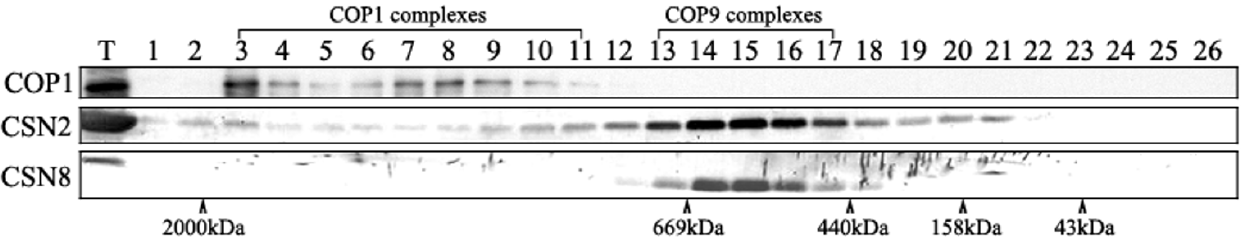
Figure 4 Gel filtration analysis of endogenous HsCOP1 protein . The nucleoplasm extract from HeLa cells was fractionated by Superose 6 column. Fractions were concentrated with StrataClean resin and subjected to immunoblot with anti-COP1, anti- CSN2 and anti-CSN8 antibodies as indicated on the left. The fraction numbers are indicated on the top of the panel. The peak positions of size markers are indicated at bottom. T, total; CSN2 and CSN8, the COP9 signalosome subunit 2 and